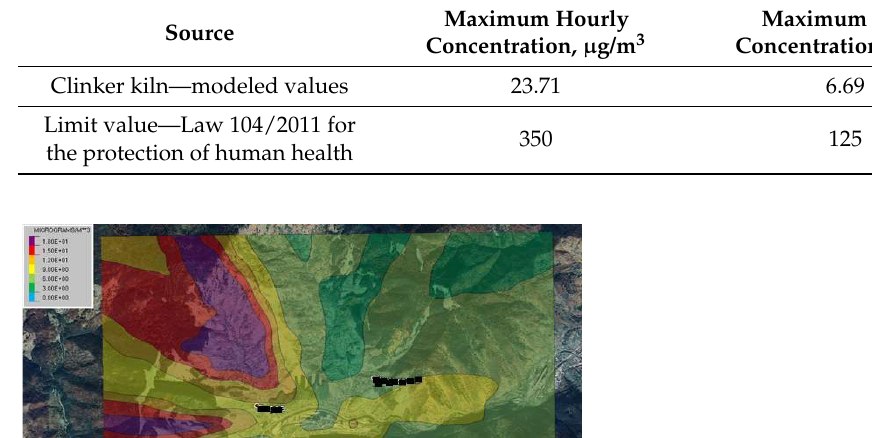
Table 11. Maximum SO 2 concentrations extracted from modeling (hourly and daily).